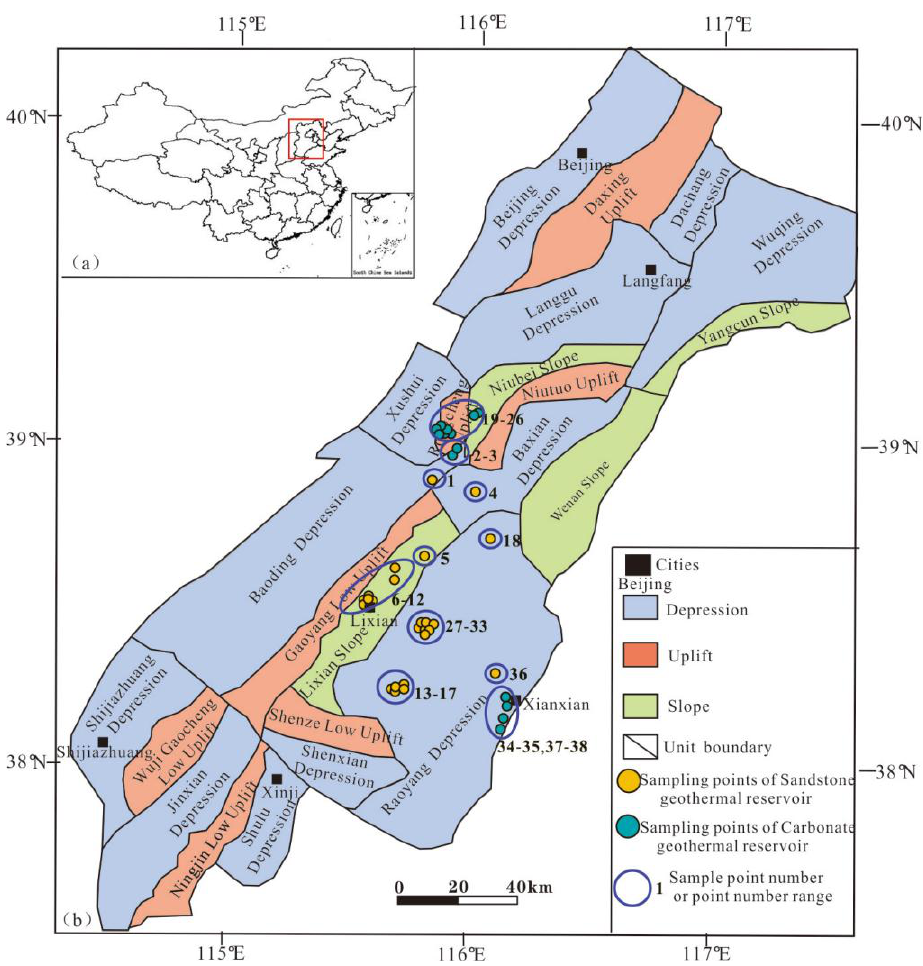
Figure 1. ( a ) Location of the study area in China (red box shows the area where the study area is located). ( b ) Tectonic zoning map of the Jizhong Depression (modified from Mao et al. [13], 2021). Table 1. Table of major ion concentrations in geothermal fluids (mg/L).